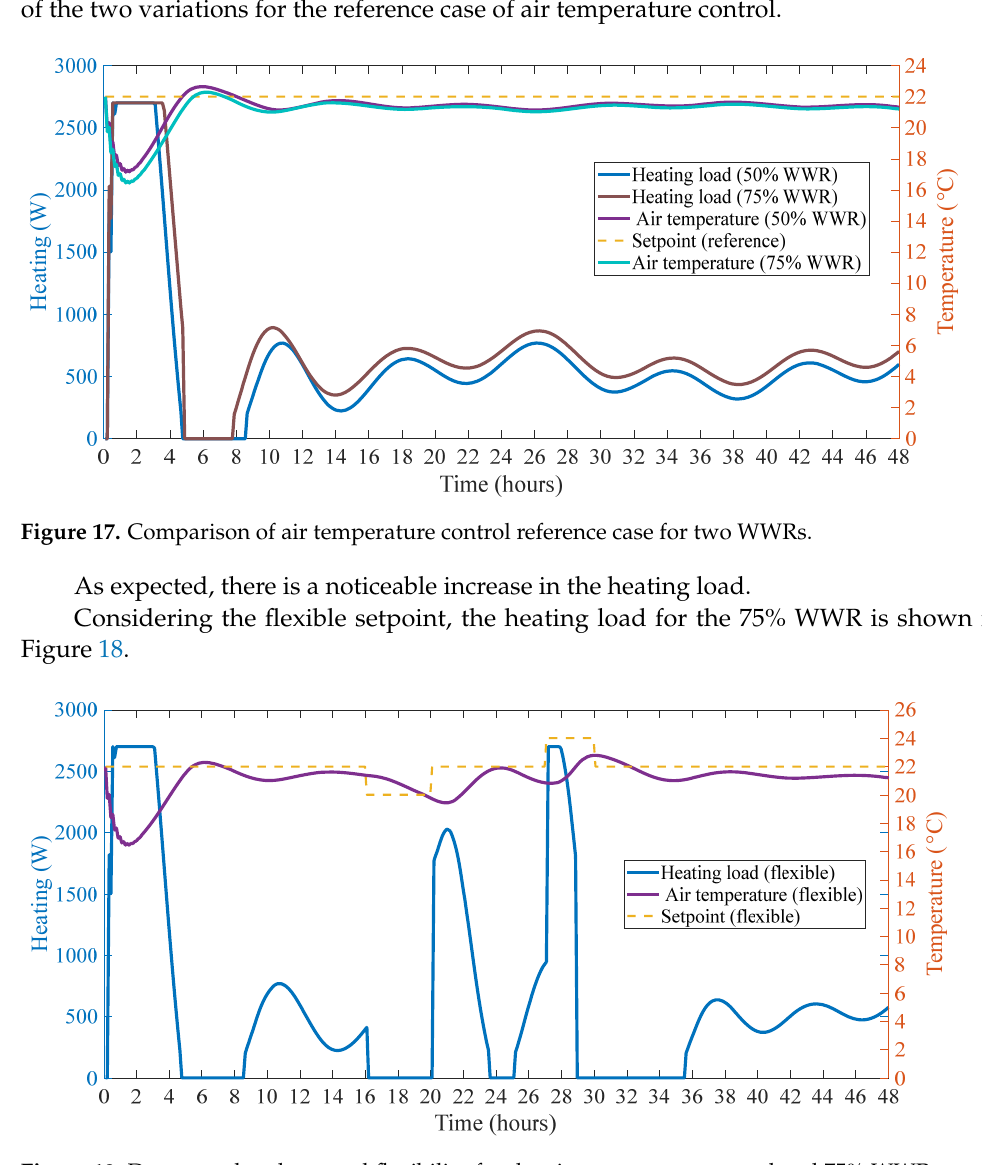
Figure 18. Downward and upward flexibility for the air temperature control and 75% WWR. The downward and upward energy flexibilities for this case are: C ADR ,D = 289 Wh/m 2 and C ADR ,U = 182 Wh/m 2 . Therefore, as the heating load is increased with increasing WWR, the downward flexibility is increased by 17%. However, in the case of upward flexibility, a decrease of 42% (from 313 Wh/m 2 ) was observed.